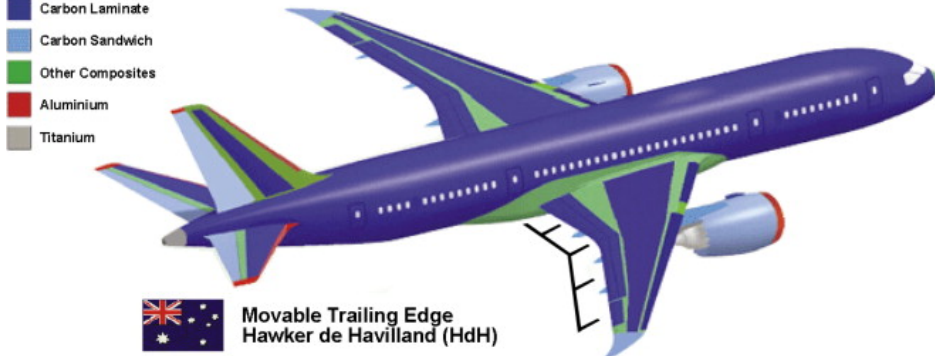
Figure 5. Material utilization in the Boeing 787 Dream Liner manufactured by HdH [24] (reprinted with kind permission from Elsevier).